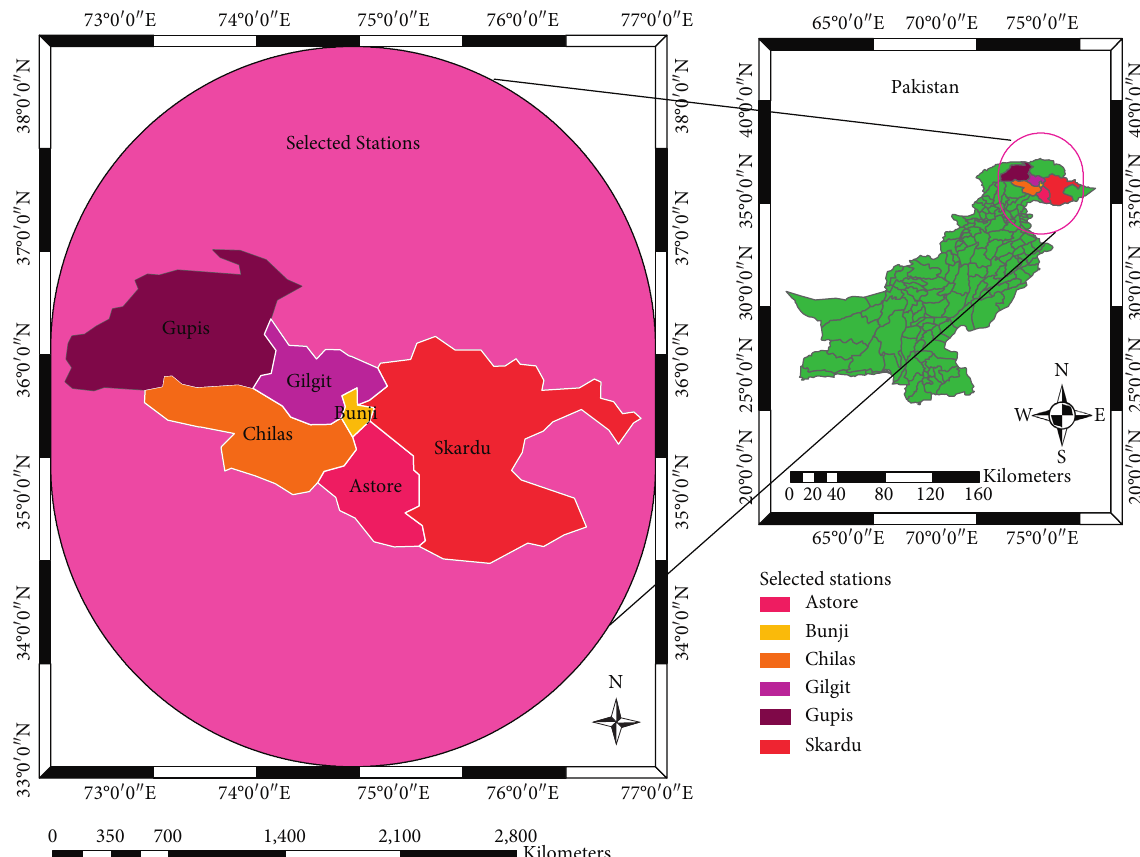
Figure 1: The study area consisting of six required stations in the northern area of Pakistan is